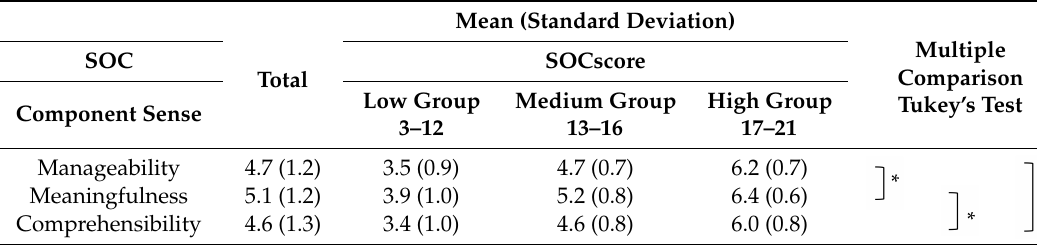
Table 1. Relationships between the SOC score and component senses in each SOC group.